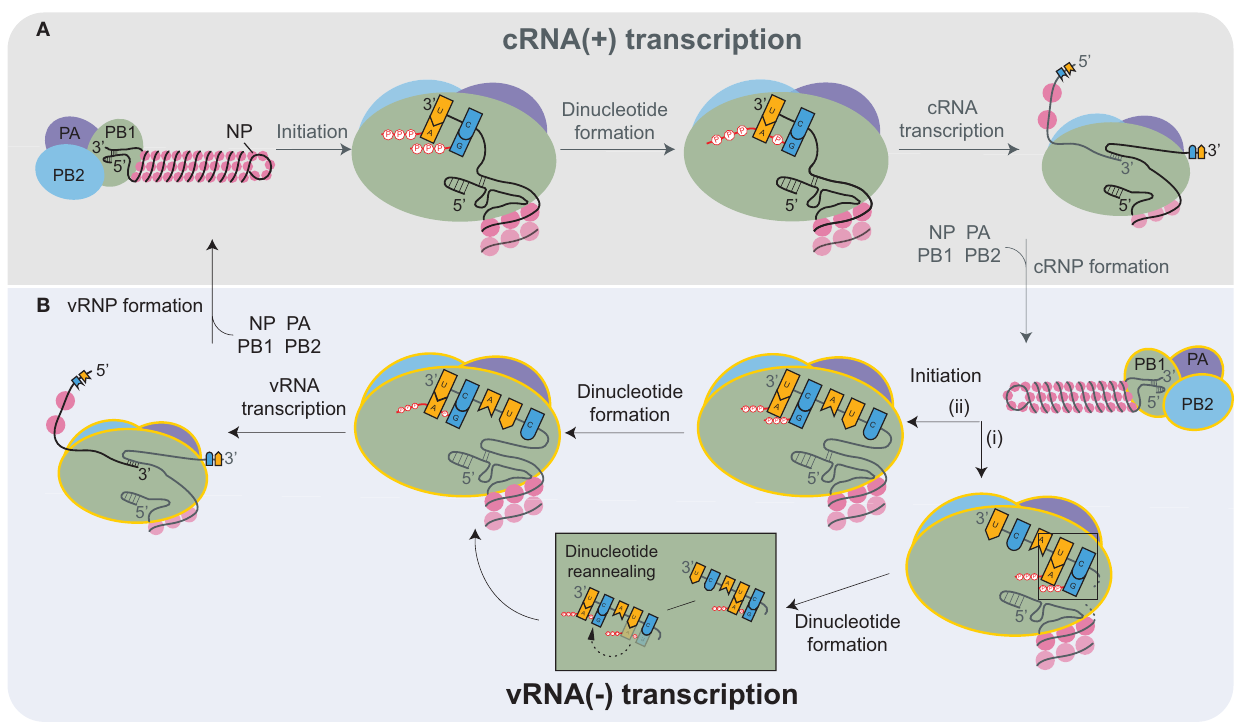
FigURe 3 | Transcription of the complimentary RNA (cRNA) and viral RNA (vRNA) by the heterotrimeric viral RNA-dependent RNA polymerase (PB2, PB1, and PA). (A) The viral polymerase initiates transcription of the positive-sense cRNA upon base-pairing of ATP and GTP with the complimentary nucleotides in the 3 ′ end of the vRNA. The subsequent formation of the A-G dinucleotide is followed by elongation of the cRNA transcript. Nucleoprotein (NP) molecules successively bind to the cRNA as it exits the polymerase, promoting cRNP assembly. cRNP formation is completed upon the termination of transcription and with the binding of a newly synthesized viral polymerase (yellow outline). (B) vRNA transcription proceeds in a similar manner as cRNA synthesis. Recent structures support a model where (i) ATP and GTP base pair to the nucleotides located 4 and 5 bases from the cRNA 3 ′ end, and there form a dinucleotide, which then disassociates and reanneals with the bases at positions 1 and 2. (ii) Alternatively, ATP and GTP could bind directly to the terminal nucleotides and form a dinucleotide. Both mechanisms would position the dinucleotide at the cRNA 3 ′ end, which is necessary to transcribe a full-length vRNA. Similar to cRNP formation, multiple NPs and a viral polymerase bind to the newly transcribed vRNA to produce a new viral ribonucleoprotein